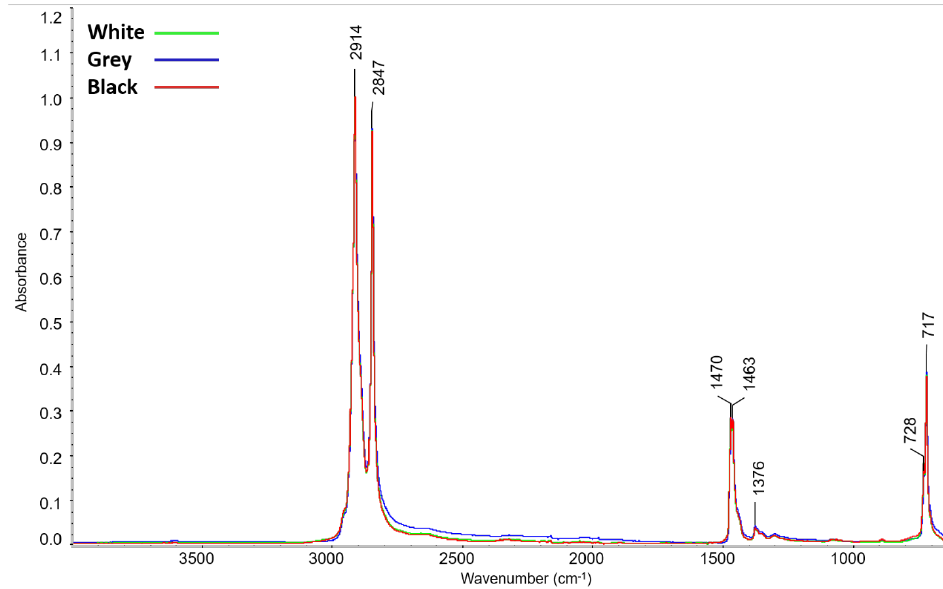
Figure 3. ATR-FTIR spectra of the tested PE foams before artificial aging.